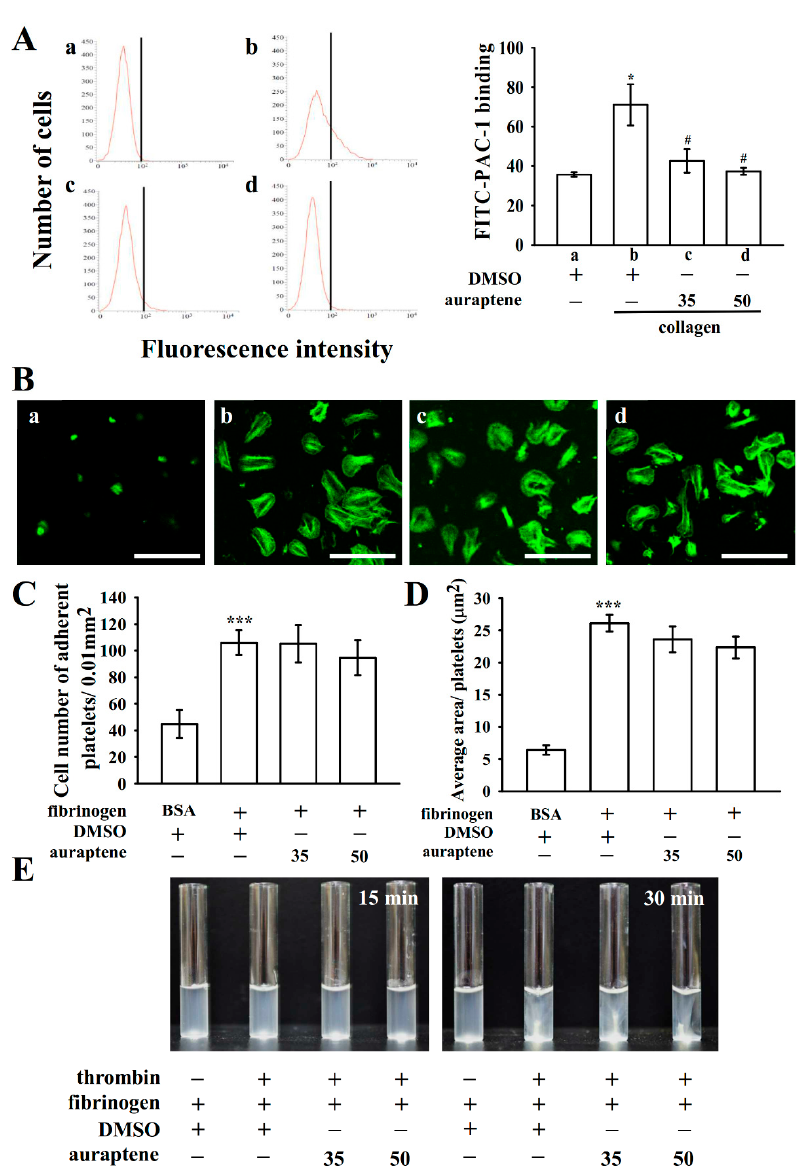
Figure 3. Controlling activities of auraptene on integrin α IIb β 3 activation, platelet adhesion, and spreading on immobilized fibrinogen as well as clot retraction. ( A ) Resting platelets (DMSO-treated) (a) or platelets were preincubated with 0.1% DMSO (b) or auraptene (c, 35; d, 50 µ M) and the FITC-conjugated anti-PAC-1 mAb (2 µ g / mL) were added before the addition of collagen for flow cytometer analysis. For other experiments, ( B ) washed platelets were allowed to spread on the (a) Bovine serum albumin (BSA)- or (b–d) fibrinogen-coated surfaces with (b) solvent control (0.1% DMSO) or auraptene (c, 35; d, 50 µ M). Platelets were consequently labeled with FITC-conjugated phalloidin, as designated in the materials and methods. ( C ) The number of adherent platelets per 0.01 mm 2 and ( D ) the average spreading surface area of individual platelets in sight views are plotted. ( E ) Washed platelets were suspended in 2 mg / mL fibrinogen with 0.1% DMSO or auraptene (35 and 50 µ M) before the thrombin (0.01 U / mL) stimulation. Images were photographed at 15- and 30-min intervals. Profiles in ( E ) are representative of four similar experiments. Data are presented as mean ± SEM ( n = 4). ( A ) * p < 0.05 and # p < 0.05, compared with the resting and DMSO-treated groups, respectively; ( C , D ) *** p < 0.001, compared with the immobilized BSA